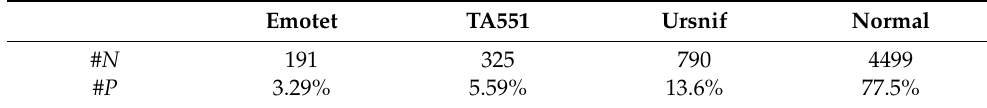
Table 5. Sample numbers of Dataset